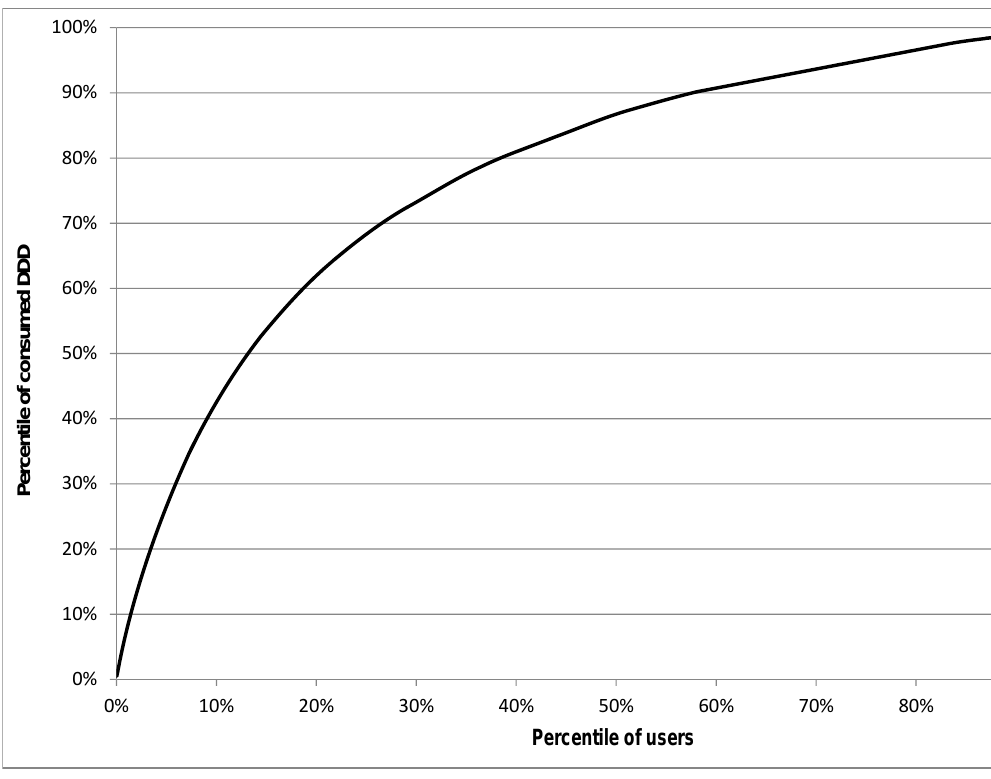
Figure 1. Lorenz curve of non steroidal anti ‐ inflammatory drugs use in the cohort of workers, 2014.